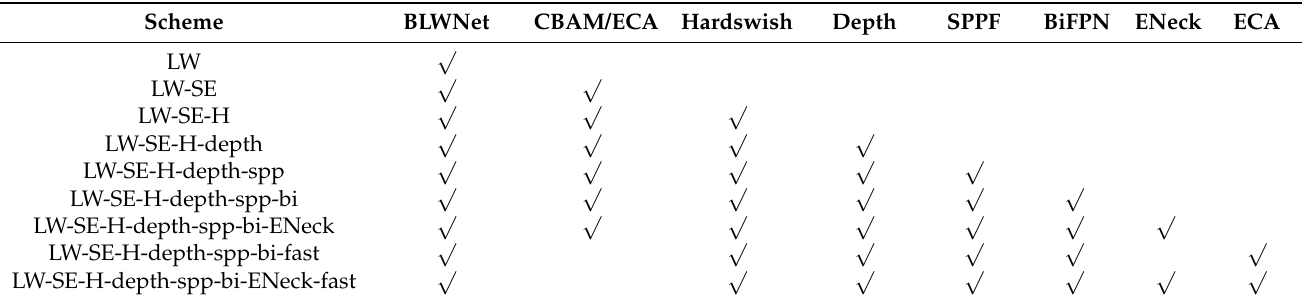
Table 6. Different improvement